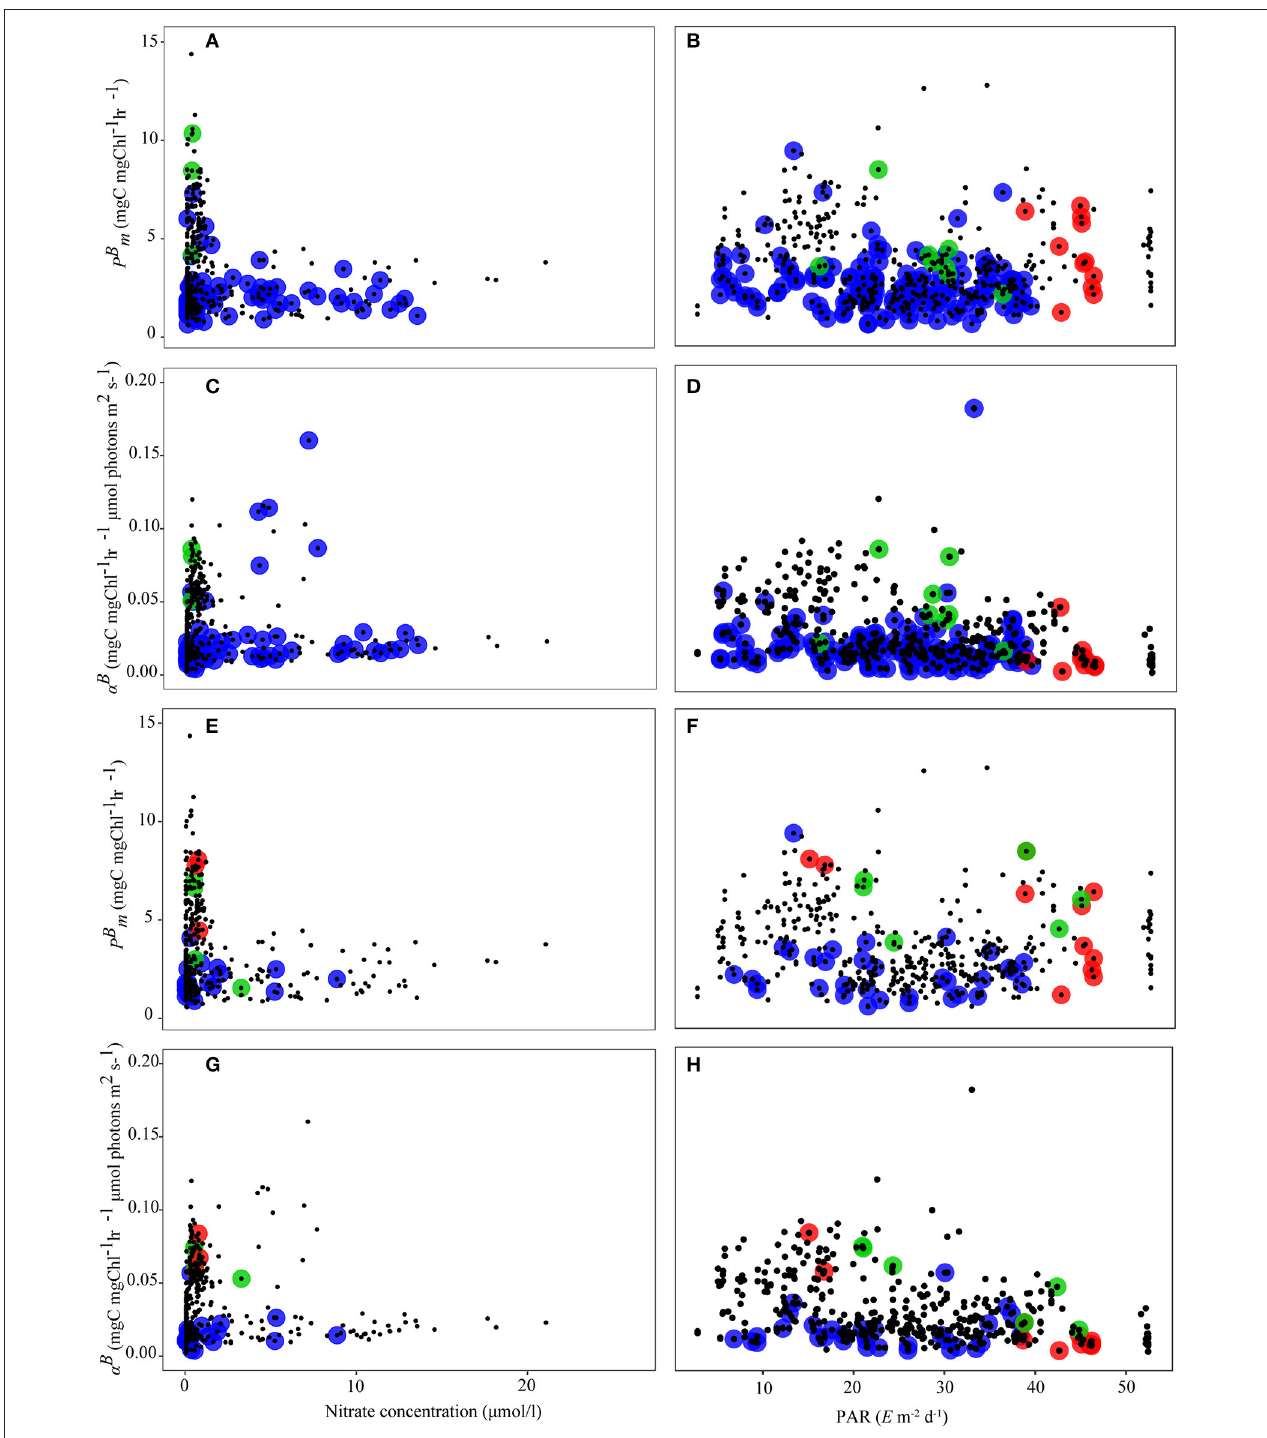
FIGURE 7 | PE parameters as a function of nitrate an PAR: (A) is Sathyendranath P B m against nitrate; (B) is Uitz P B m against nitrate; (C) is Sathyendranath α B against nitrate; (D) is Uitz α B against nitrate; (E) is Sathyendranath P B m against PAR; (F) is Uitz P B m against PAR; (G) is Sathyendranath α B against PAR; (H) is Uitz α B against PAR; Micro-phytoplankton ( > 20 µ m) is blue circles, nano-phytoplankton (2–20 µ m) is green circles, and pico-phytoplankton ( < 2 µ m) is red circles. Black points represent samples classified as “mixed” populations.